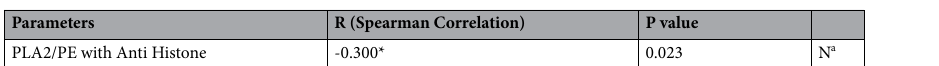
Table 4. Spearman’s correlations between PLA2/PE and anti- histone. * Correlation is significant at the 0.05 level. a Negative Correlation.